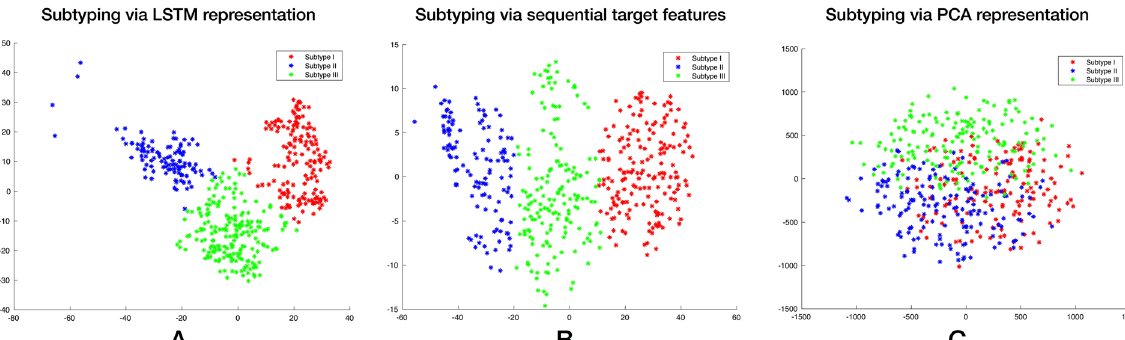
Figure 2. Visualization of patient subtyping results by various methods. ( A ) Representation learned by LSTM. ( B ) Dynamic time warping using sequential target features. ( C ) Representation learned using PCA with merging sequential data into static vectors. Patients are mapped to the 2-dimensional space using the t-SNE with learned representations as input. Points with three different color represent three subtypes of